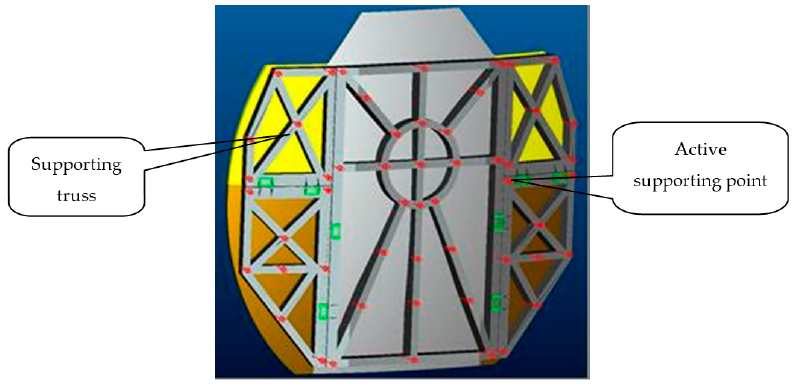
Figure 2. Truss structure of the antenna panel.